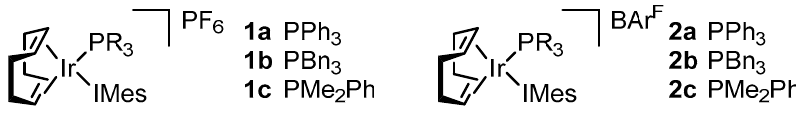
Figure 1. Iridium(I) N-heterocyclic carbene (NHC)/phosphine complexes for directed hydrogen isotope exchange.